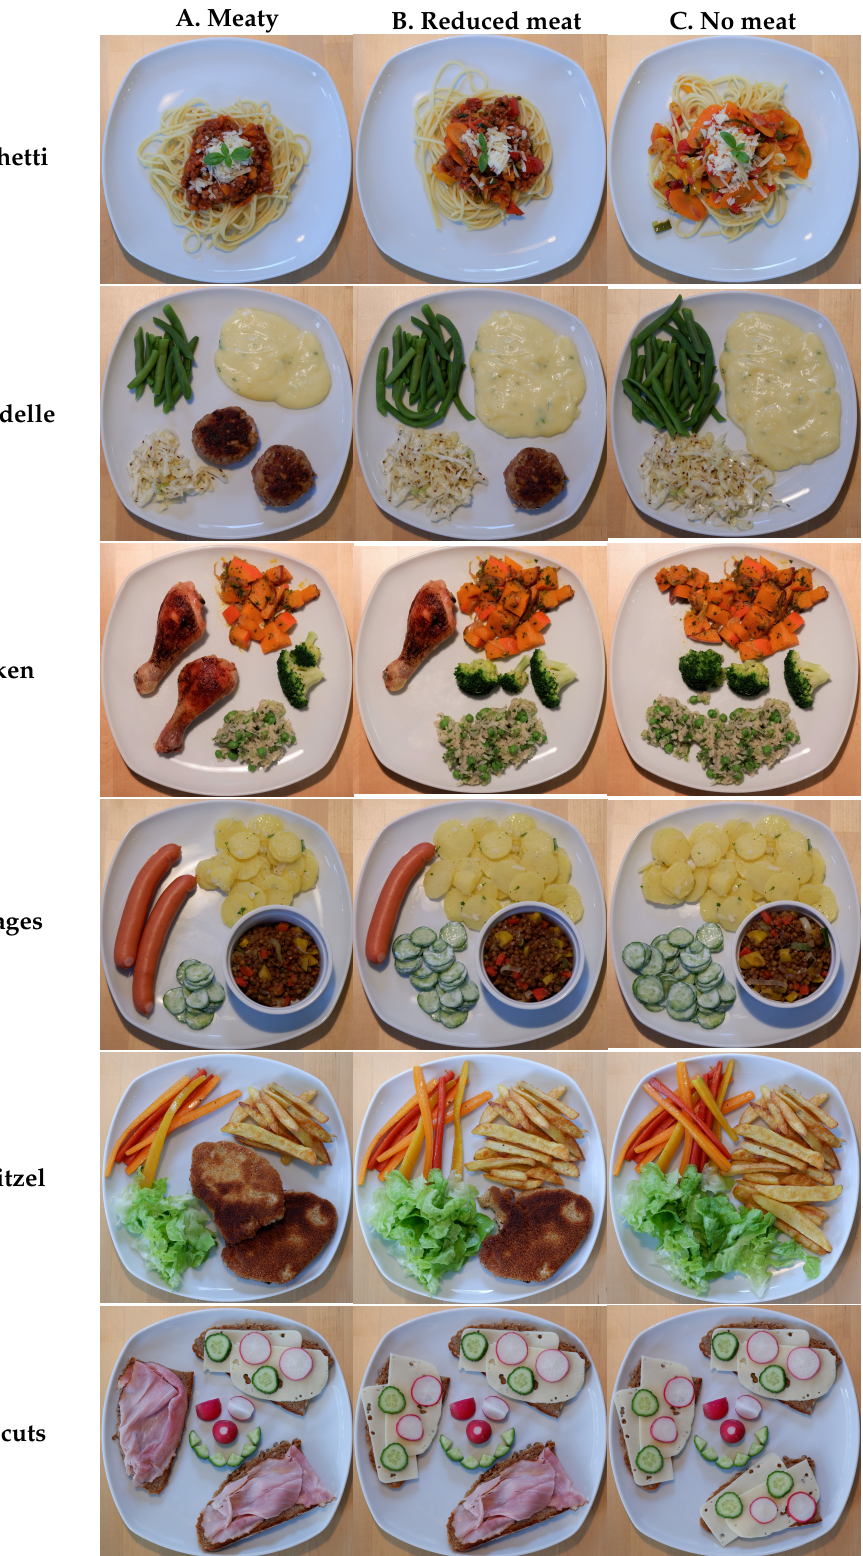
Figure 1. Photographs of the 6 dishes, left to right: ( A ) meaty, ( B ) reduced meat, ( C ) no